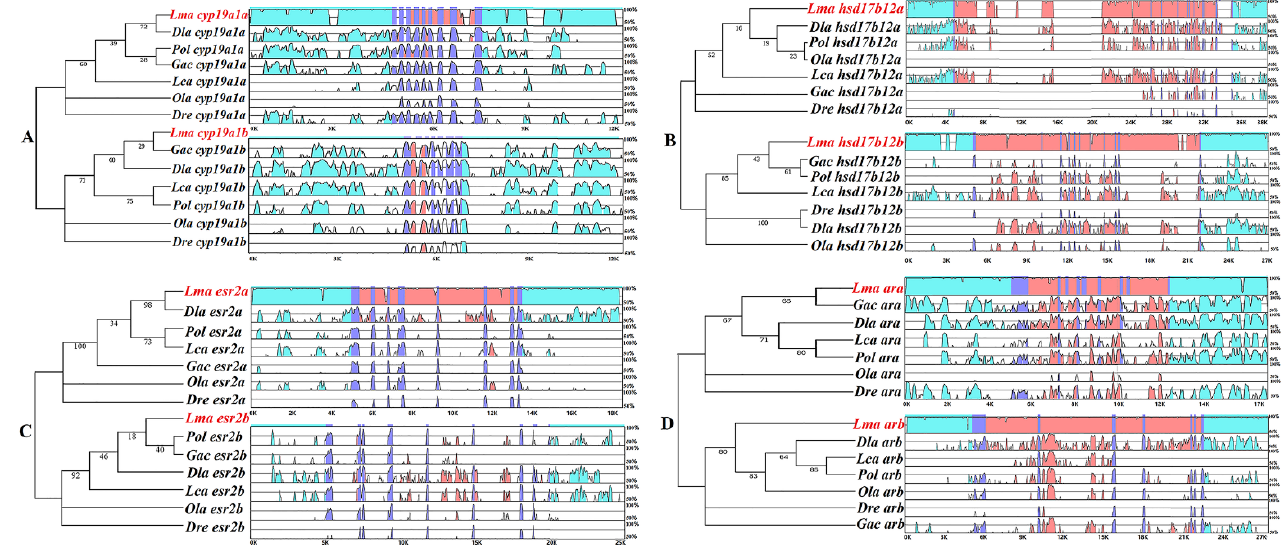
Figure 3. Conserved sequence structures of HPG axis genes in teleost lineages, as determined by mVISTA analysis. ( A ) cyp19a1a/cyp19a1b . ( B ) hsd17b12a/hsd17b12b . ( C ) esr2a / esr2b . ( D ) ara/arb . Blue coloring represents intergenic regions; purple coloring represents exon regions; orange coloring represents intron regions. The similarities in gene structure among L. maculatus and selected teleosts that were higher than 50% are displayed in color. The genes of the L. maculatus HPG axis are shown in red font, enlarged italics, and bold.